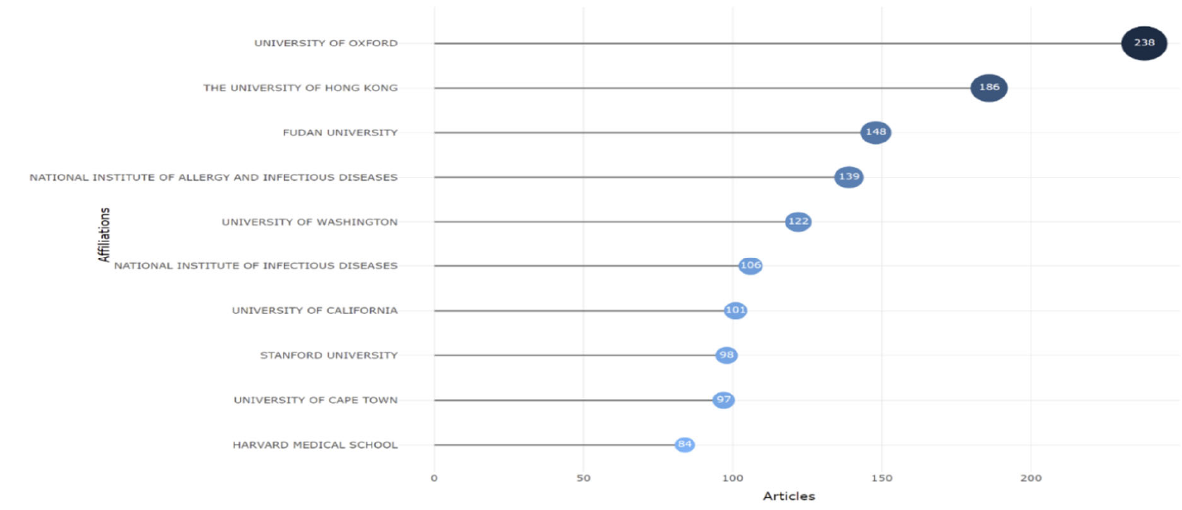
Figure 5. Top ten relevant affiliations contributed to Omicron research.